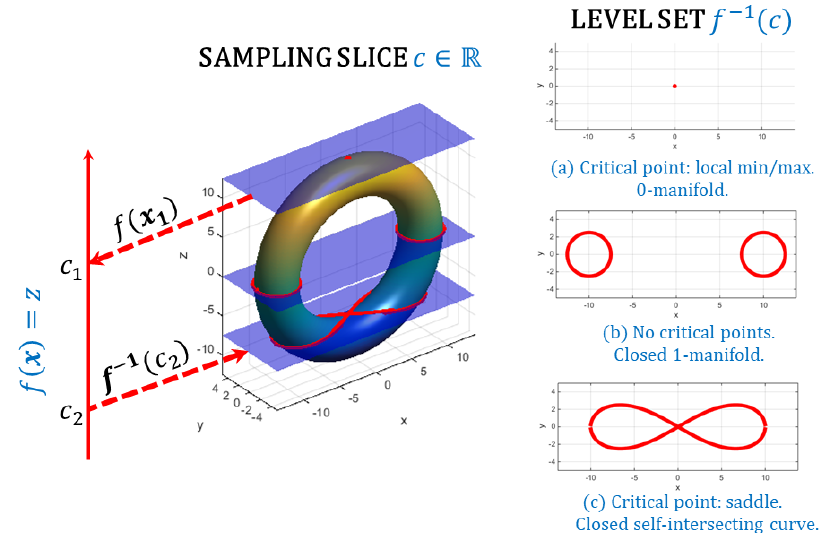
Figure 1. Type of level sets f − 1 for a Morse function f . f is a slicing function defined on a closed 2-manifold M ⊂ R 3